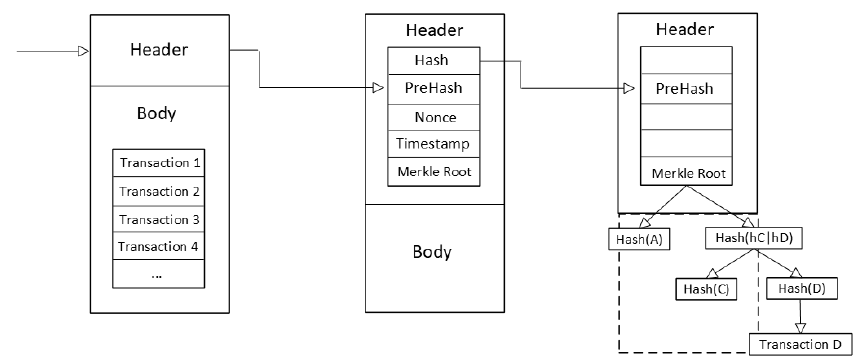
Figure 4. blockchain